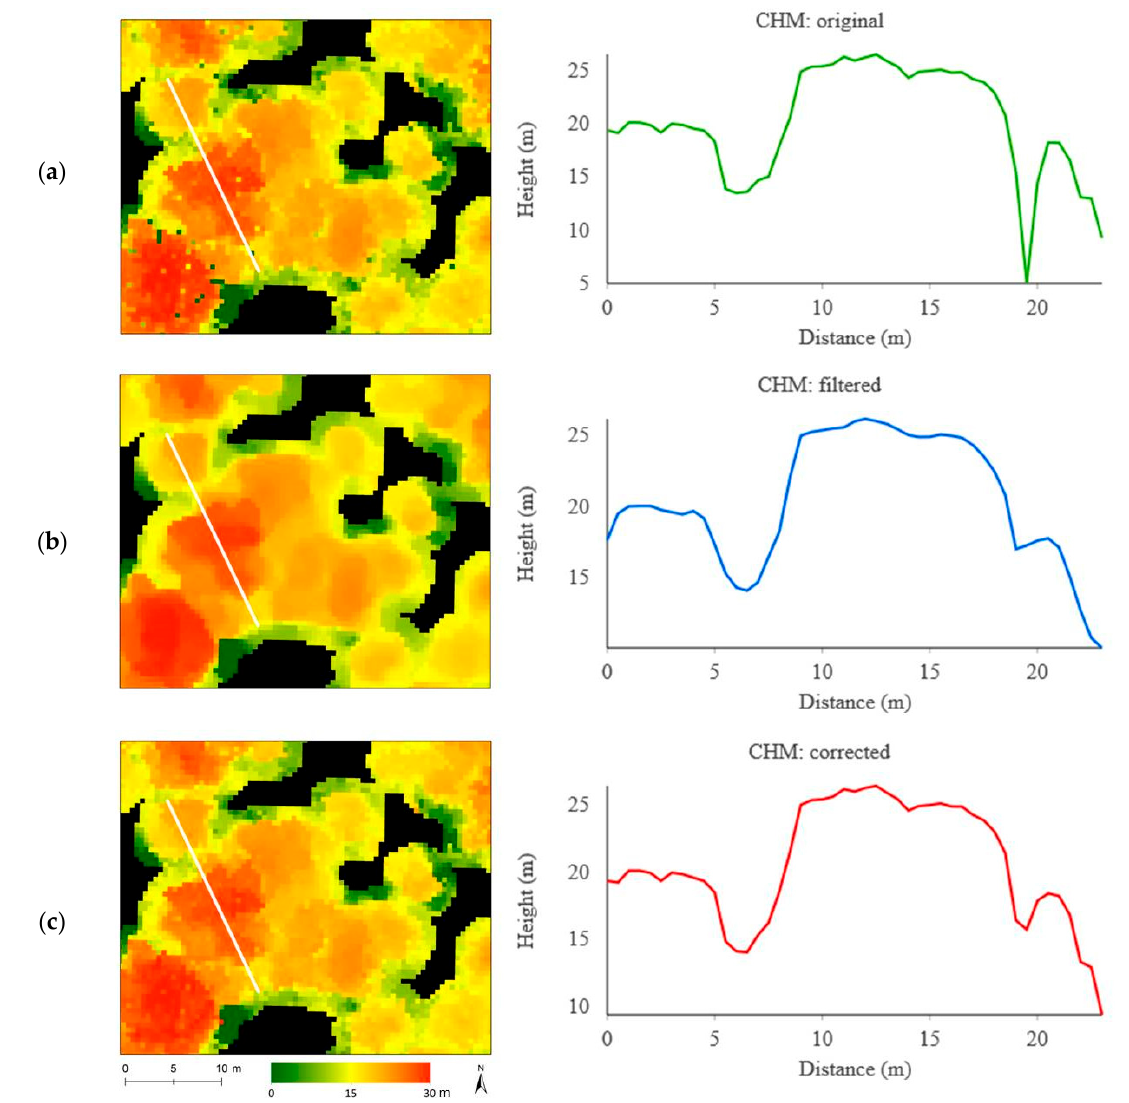
Figure 3. The three canopy height models (CHMs) used to make individual tree crown (ITC) segmentation. ( a ) original CHM; ( b ) filtered CHM; and ( c ) corrected CHM.